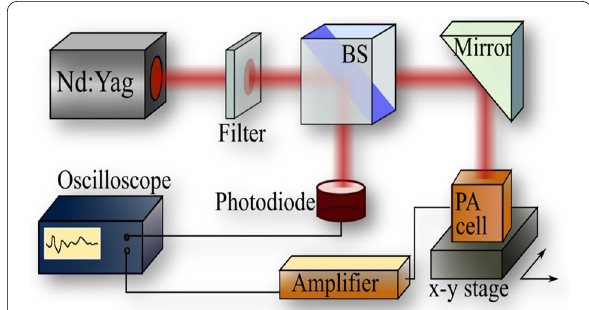
Fig. 3 Scheme of the photoacoustic experimental